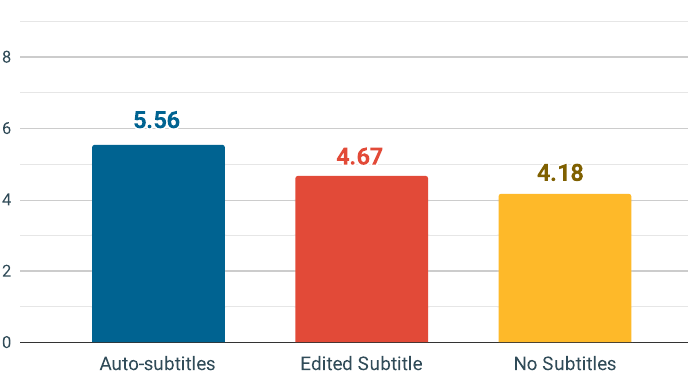
Fig. 2 Estimated marginal means of overall learning comprehension controlling for English listening